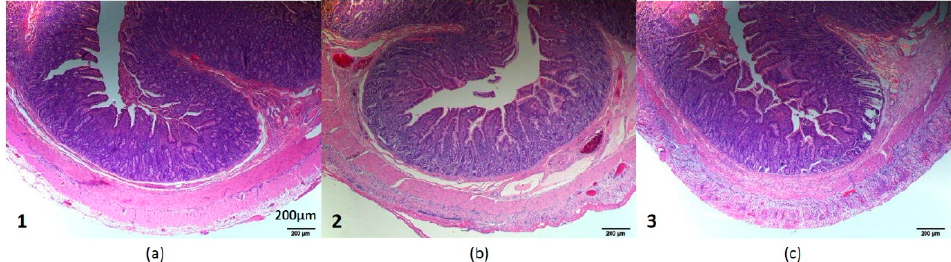
Figure 10. Intestinal-tissue histology. ( a ) Normal jejunum distal to the surgical site (Section 1), ( b ) jejunum that was attached to planar electrode array but did not receive stimulation (Section 2), and ( c ) jejunum that was attached to planar electrode array and received stimulation (Section 3).